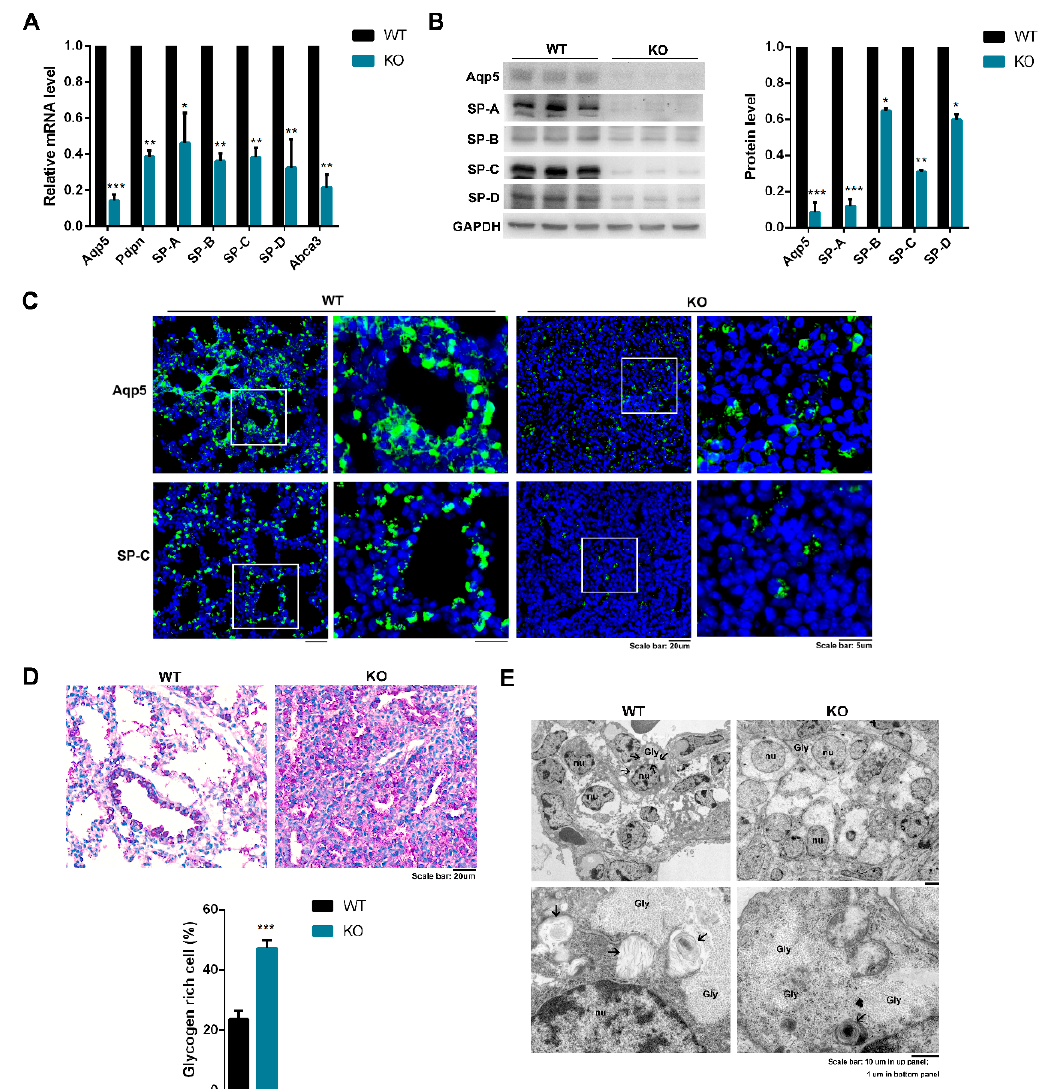
Figure 5. Kub3 deletion impairs the differentiation of alveolar epithelial cells and the maturation of AECIIs. ( A ) Quantitative RT-PCR analysis of the mRNA levels of marker genes for AECIs and AECIIs in E18.5 lungs. The data are derived from three independent experiments performed in triplicate and are normalized to the GAPDH ( n = 3. *** p < 0.001, ** p < 0.01, * p < 0.05). ( B ) Immunoblot analysis of protein levels of AECI and AECII markers. GAPDH expression was used as a loading control. The ratios to GAPDH expression are represented by bar graphs ( n = 3. *** p < 0.001, ** p < 0.01, * p < 0.05). ( C ) Immunostaining of Aqp5 and SP-C in lung sections between WT and KO at E18.5. The images on the right enlarged from box regions are in high magnification. Scale bar: 20 µ m and 5 µ m. ( D ) Periodic acid–Schiff (PAS) staining in the lung sections of E18.5 lungs. Scale bar: 20 µ m. The statistical analysis of glycogen-rich cells among alveolar epithelial cells is presented by the bar graph; *** p < 0.001. ( E ) Transmission electron microscopic images of E18.5 lungs. Wild-type AECIIs contained numerous lamellar bodies (LBs) (arrows), but lamellar bodies were barely observed in KO lungs, and the cytoplasm was occupied by glycogen. Gly—glycogen deposit; Nu—nucleus. Scale bar: 10 µ m in upper panel; 1 µ m in bottom